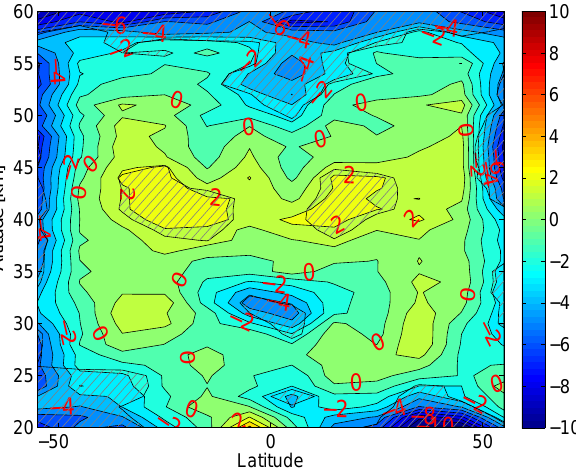
Fig. 16. The change in ozone trends in % per decade between the periods 1997–2011 and 1984–1997 at different latitudes. Shaded areas show regions where trend differences are statistically different from zero at the 95%